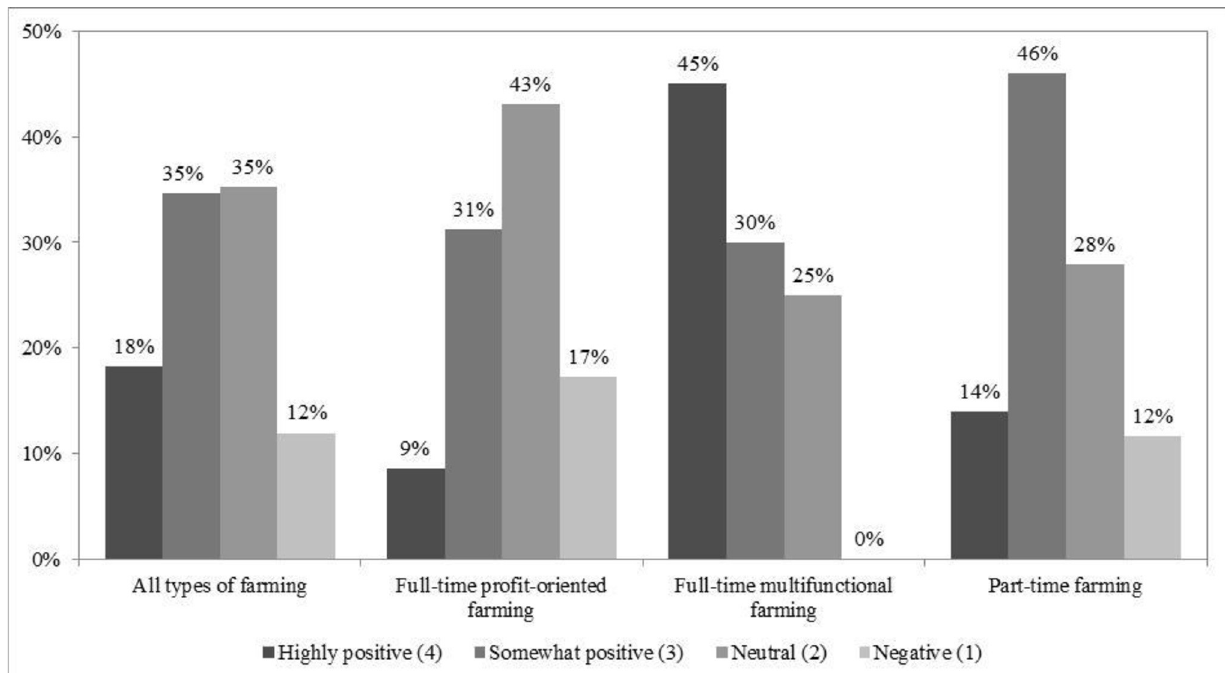
Fig 3. Attitudes towards farming. Note: 1) n = 176 and 2) Kruskal-Wallis H test ( χ 2 ) = 25.03, significant at 1% level.